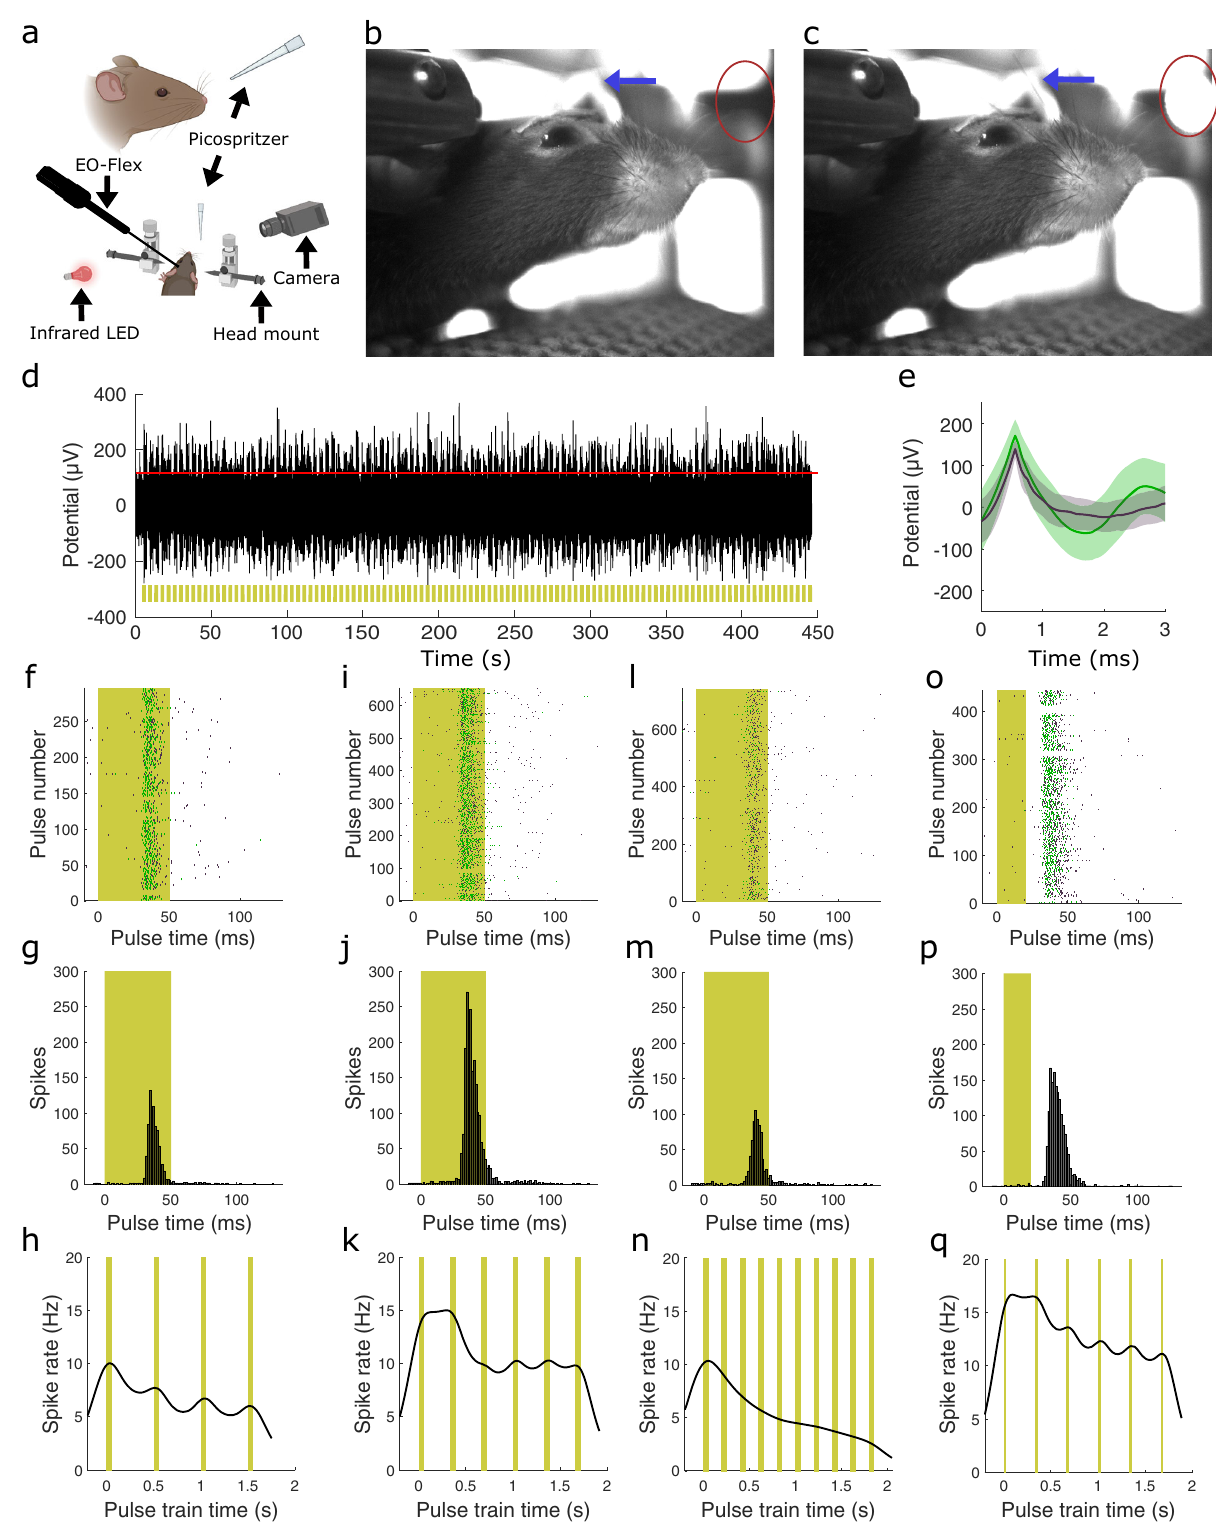
calcium spiking in C1V1-positive neurons within the fi eld of view (Fig. S12). The successful optical evocation of neural activity was also veri fi ed by simultaneous electrical recordings (Fig. S12e). Together, our in vivo data demonstrate the ability of the EO-Flex probes to electrically record and optically modulate neural activity in the intact